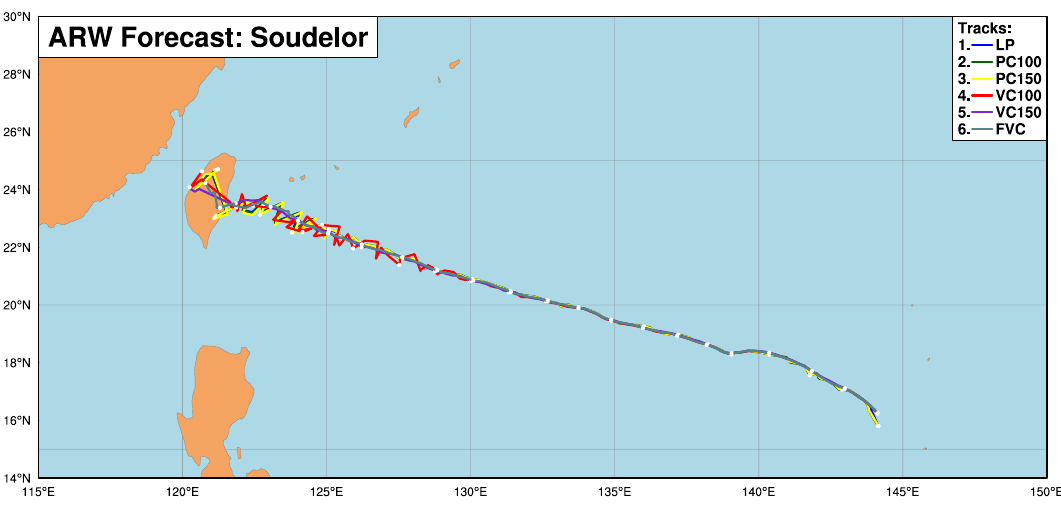
Figure 8. Tracks of Typhoon Soudelor (2015) with every 6-h position from 0000 UTC 3 August to 0000 UTC 8 August 2015 based on the six center-finding